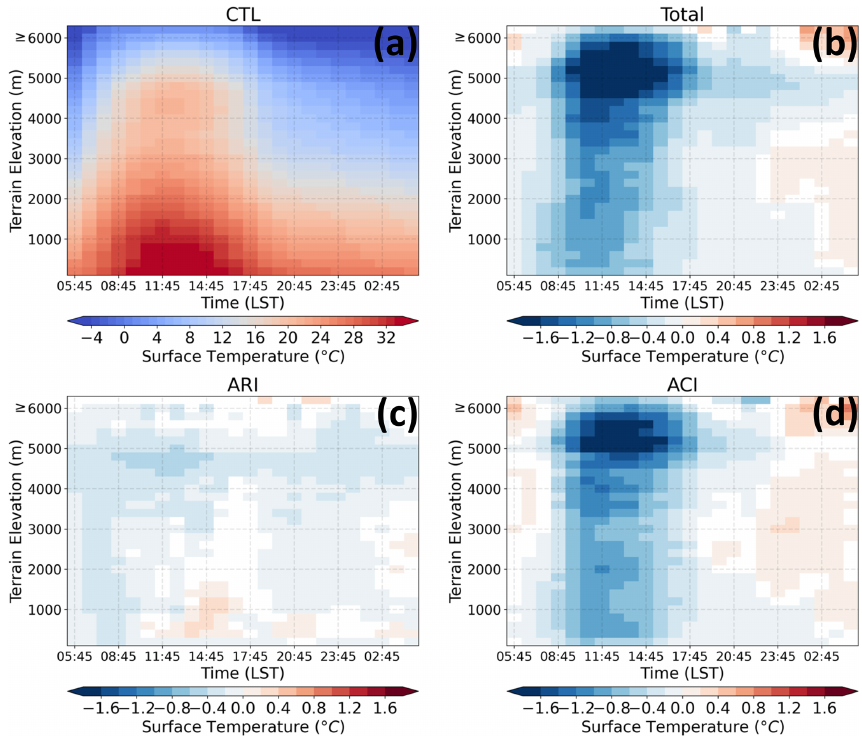
Figure 13. Elevation-dependent temperature for (a) CTL, (b) aerosol effect (CTL–CLEAN), (c) ARI effect (CTL–NoARI), and (d) ACI effect (NoARI–CLEAN) and their diurnal variability. Only the differences that are significant at the 90% confidence level based on the Student t test are